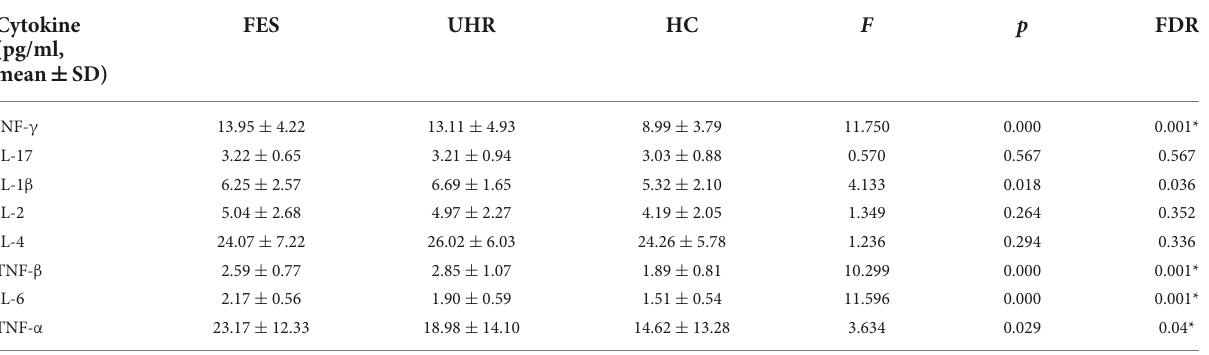
TABLE 2 Cytokine levels among three groups (FES, UHR, and